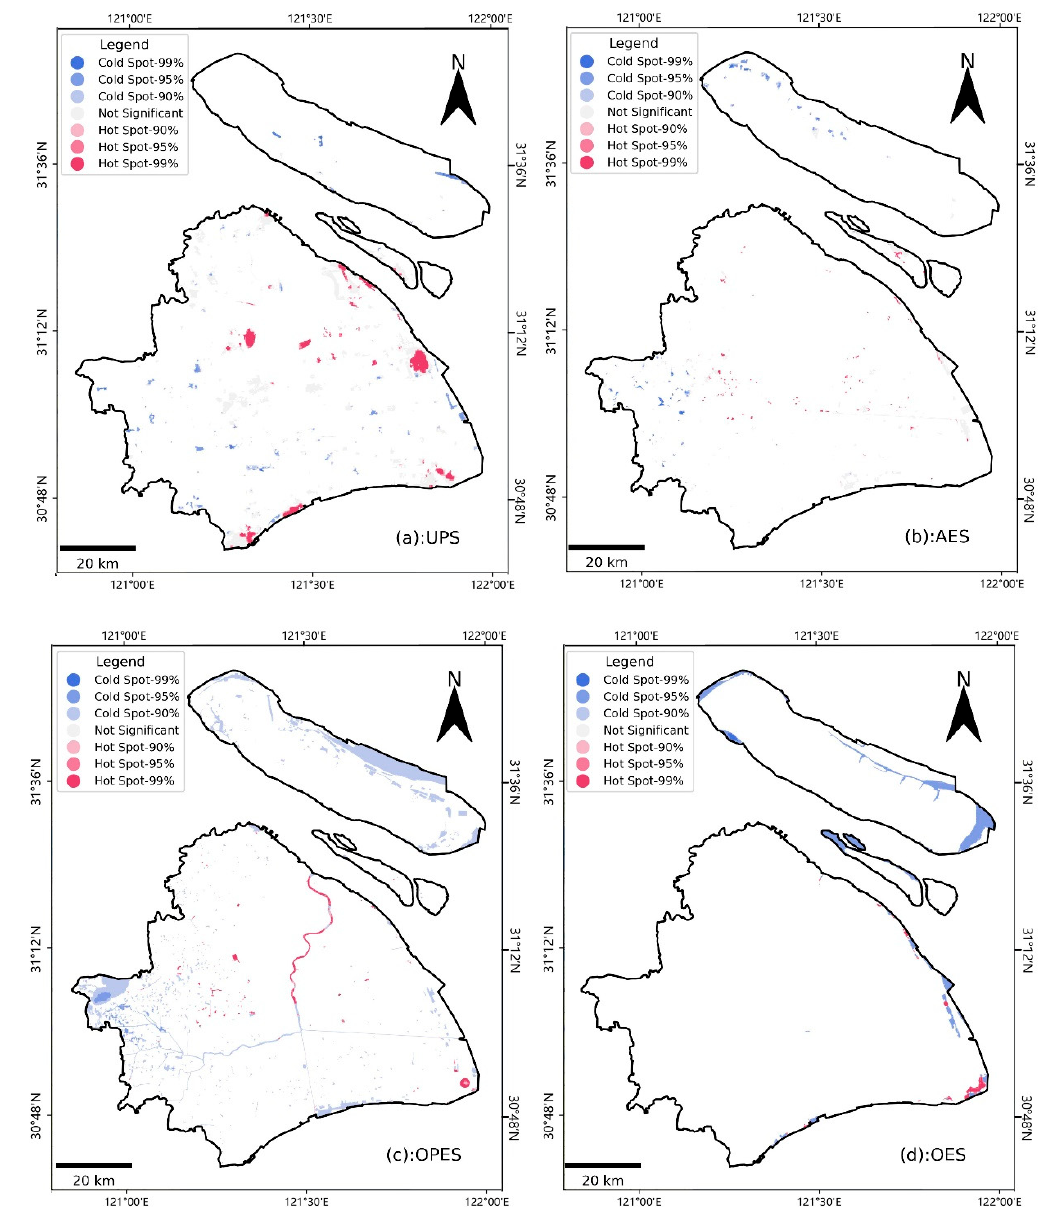
Figure 7. Space exploration results (2).